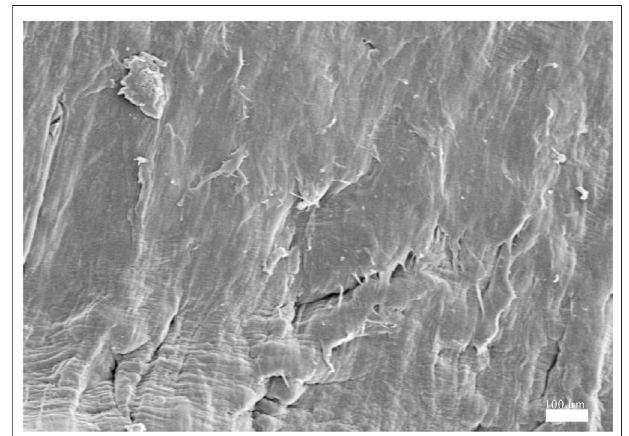
FIGURE 6 | Microstructure morphology of the HDPE geonet before the start of stretching.